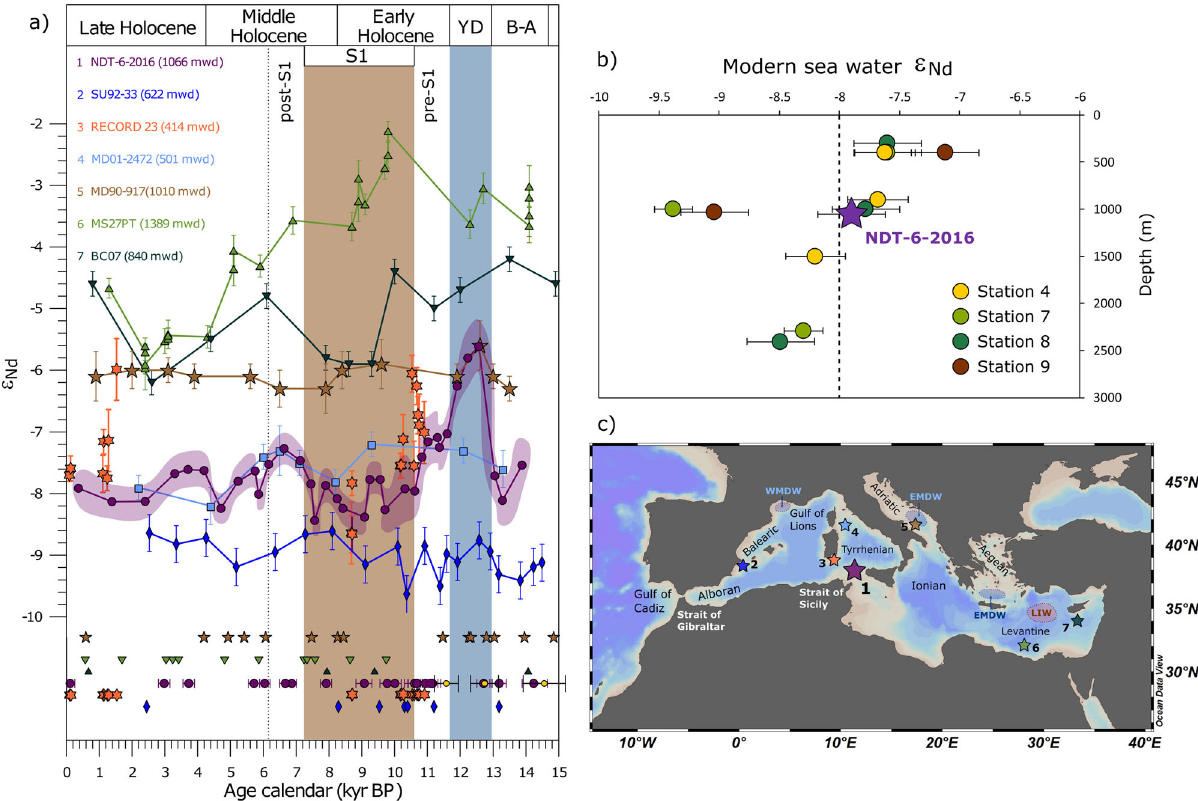
Fig. 2 Neodymium isotopes records from Mediterranean Sea. a Records of Neodymium isotopes in planktic foraminifera from NDT-6-2016 (this study), SU92-33 and RECORD23 41 , MD01-2472 and MD90-917 39 , MS27PT 42 and BC07 51 (violet circles, blue diamonds, orange six pointed stars, light blue squares, brown fi ve pointed stars, light green upward triangles and dark-green downward triangles, respectively). The 14 C-calibrated dates used for each chronology are colored according to the corresponding record. In the sediment core NDT-6-2016, violet circles represent 14 C-calibrated dates and yellow circles represent tie points. Violet shading correspond to the uncertainties of ε Nd results (2sd) of the studied core NDT-6-2016. Error bars re fl ect the other plotted records uncertainties reported in the bibliography. Grey-blue bar represents YD and light-brown bar, the S1. b Modern ε Nd seawater values for the Tyrrhenian Sea area 60 (circles) and ε Nd seawater from uppermost sample of NDT-6-2016 (studied core). Dashed line indicate the calculated modern average ε Nd seawater value of the Tyrrhenian Sea area through the stations 4, 7, 8, and 9. Error bars re fl ect uncertainties associated to ε Nd results (2sd). c Map of the study area in the Mediterranean Sea with the discussed sites